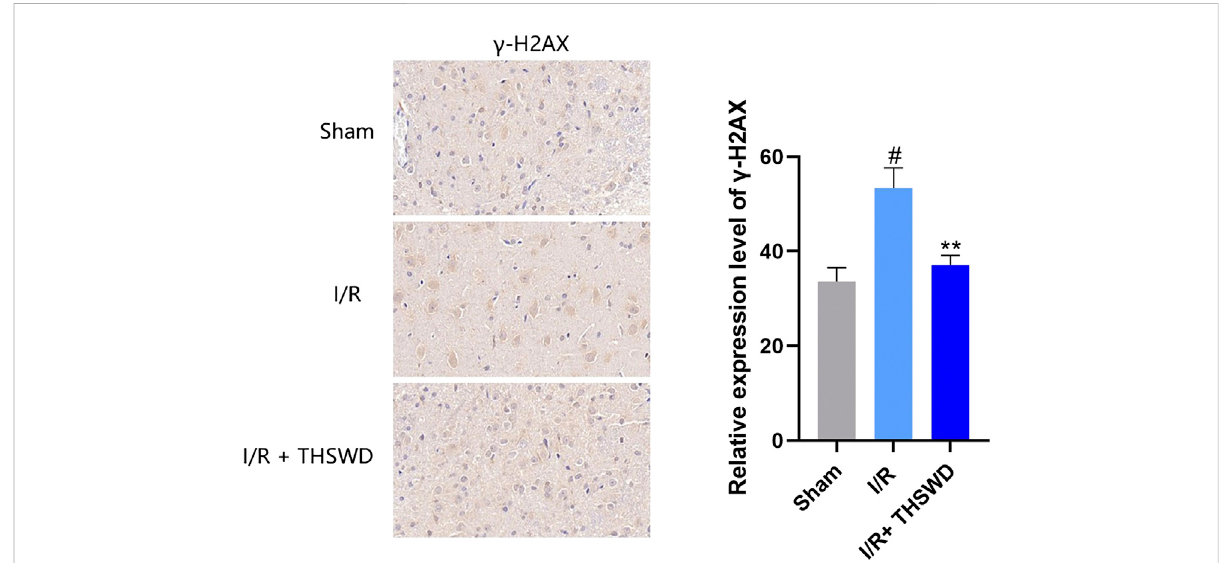
FIGURE 7 Expression of γ -H2AX in each group. Notes: # p < 0.01 vs. Sham group; ** p < 0.05 vs. I/R group.